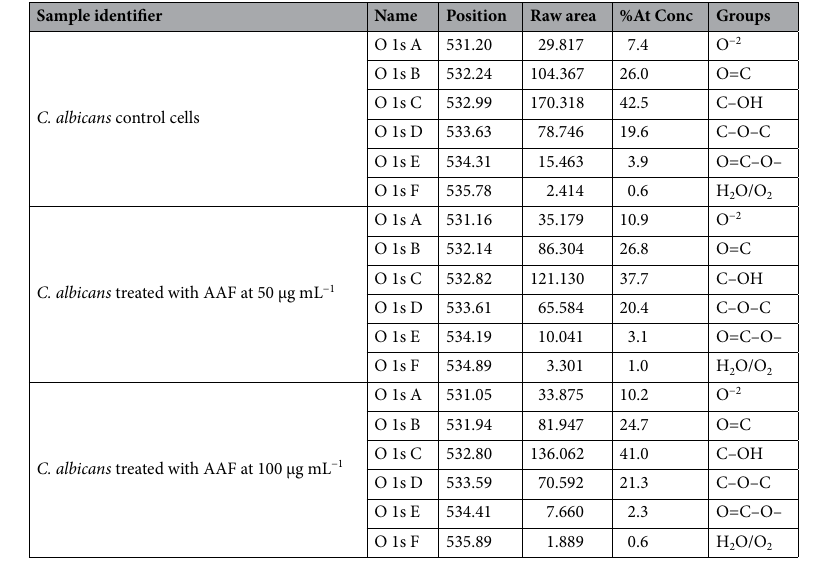
Table 4. Quantitative results of the XPS analysis of the elemental composition of the surface of C. albicans control cells and C. albicans cells incubated with AAF at the concentration of 50 µg mL −1 and 100 µg mL −1 .